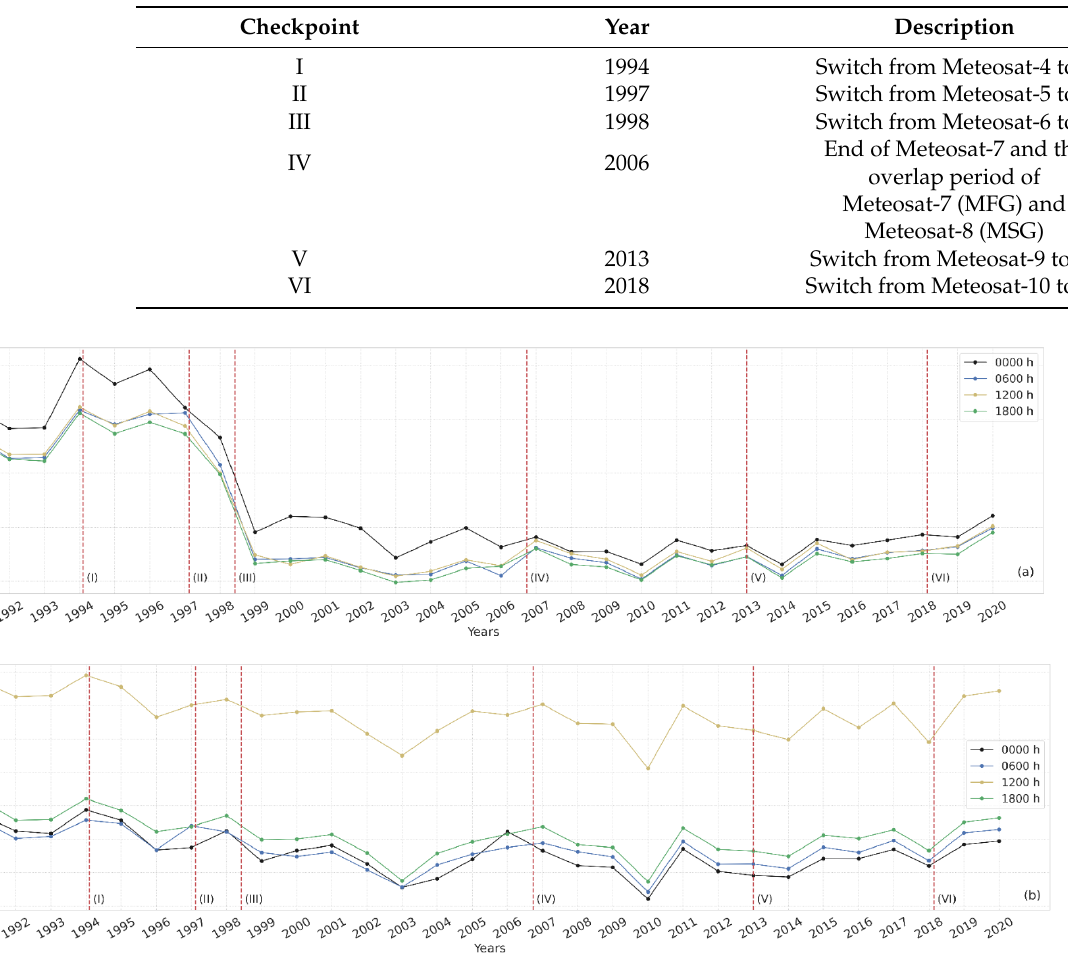
Table 4. Description of the checkpoints placed in the time series plots (in Figure 15) to check the homogeneity of the long-term datasets. The black dashed line after checkpoint IV marks the separation between MFG original and synthesized datasets.